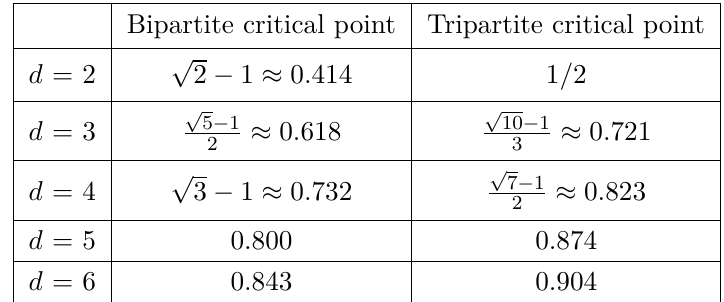
Figure 11 . The ratio E W ( A : B ) /E W ( A : BC ) in the S B phase for the pure AdS d +1 geometries as a function of s/l in the symmetric configuration. The thick curves and dots show results in the region where the S phase is dominant whereas the thin curves show the results in the region where B the S phase is subdominant. B